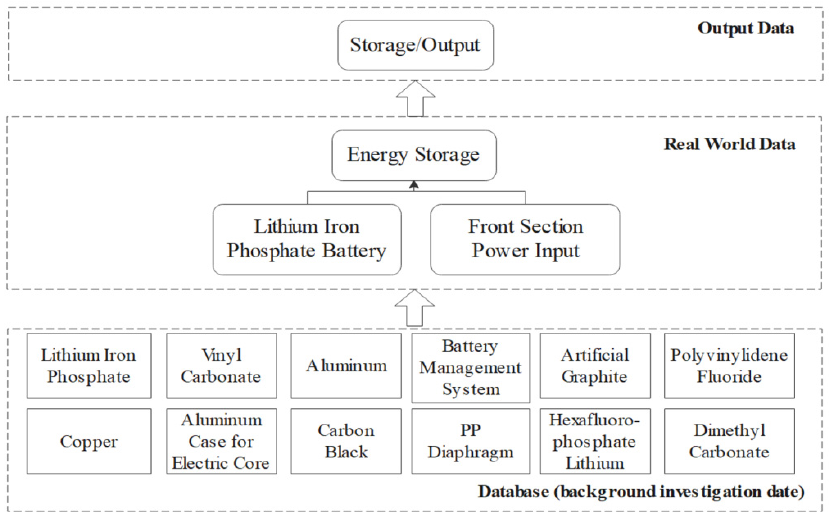
Figure 5. System boundary of the Guangdong Power Grid for users.